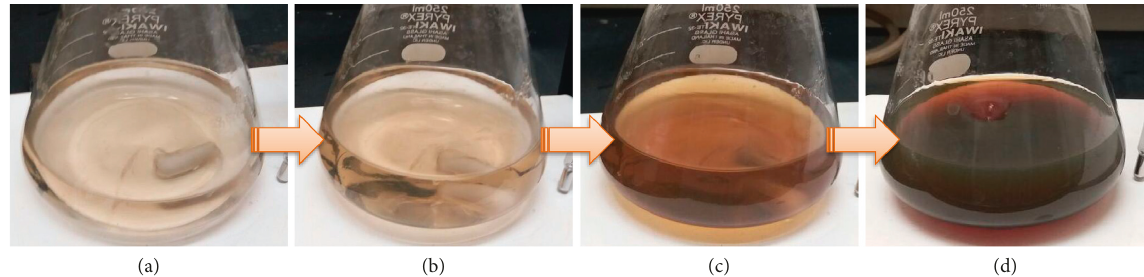
Figure 1: Color change during the synthesis of AgNPs depicting different stages of the reaction. (a) Dissolving of silver precursors into water remained transparent. (b–d) Introduction of the reducing agent (trisodium citrate) caused the reduction of precursors as appeared in color change from transparent to greenish